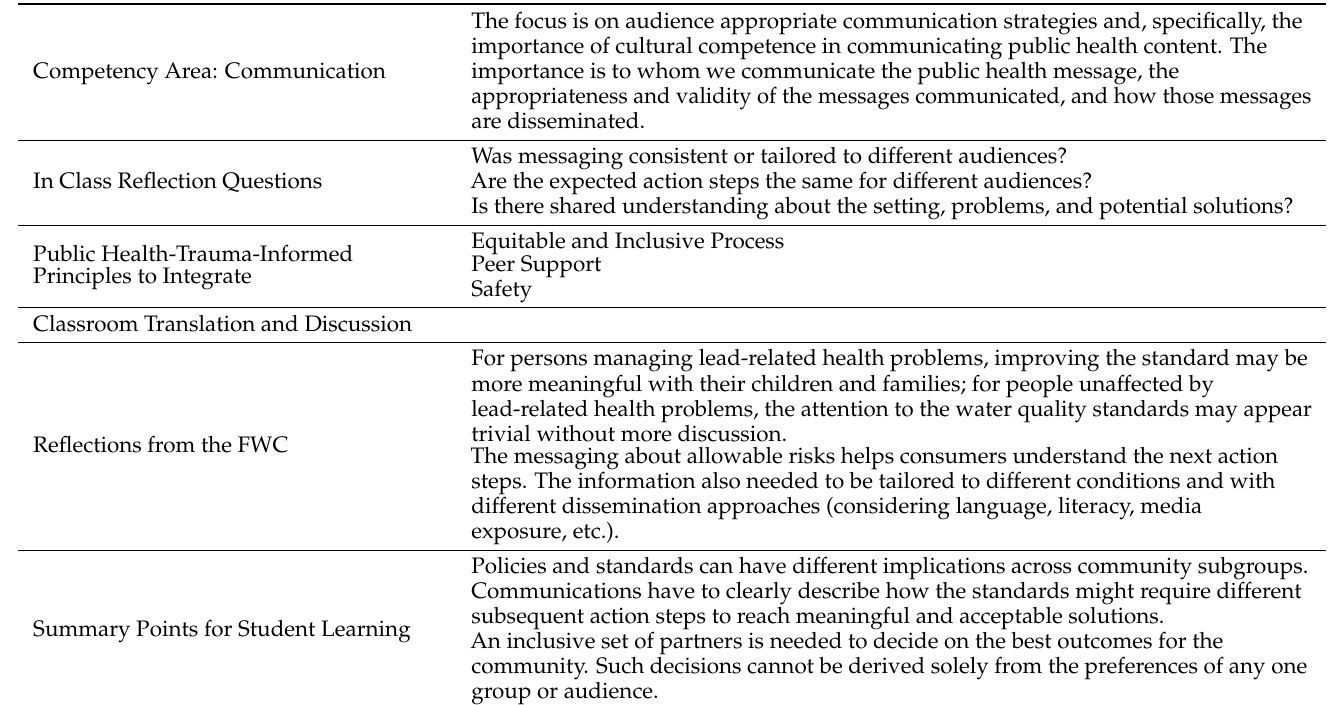
Table 7. Trauma-Informed Principles in Public Health: Addressing Public Health Communication with Examples from the Flint Water